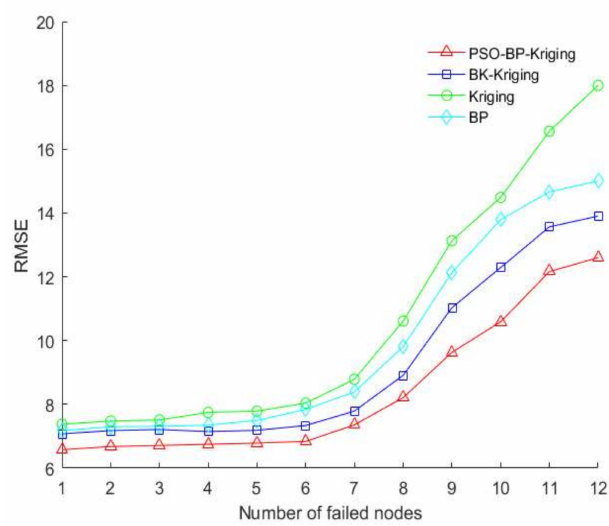
Figure 5. Relationship between RMSE and number of failed nodes in different